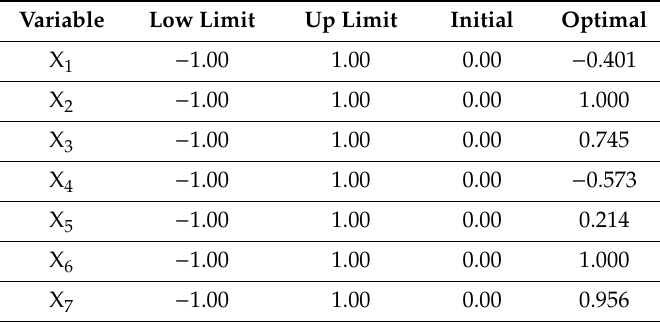
Table 1. Change of Design Variable Coe ffi